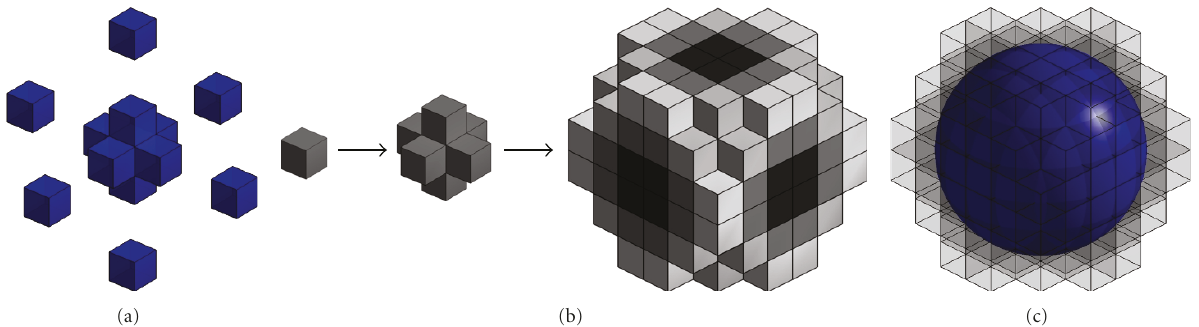
Figure 2: (a) The cross-shaped mask, (b) the adjacency-based grouping process, (c) a 3mm diameter sphere placed at the calculated marker centre.